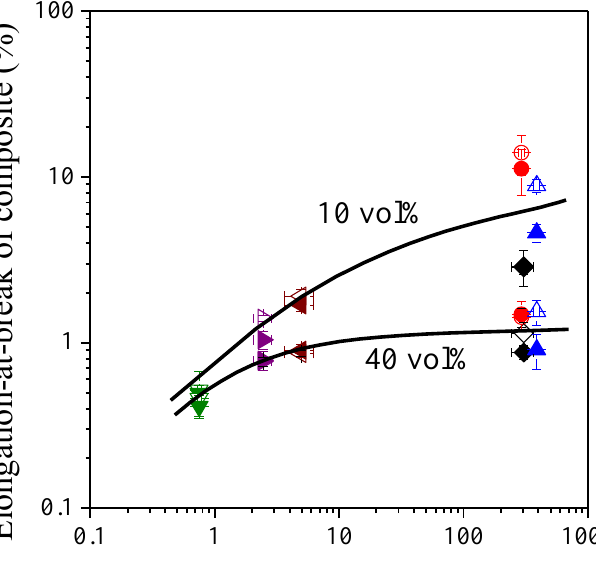
Figure 5. Effect of filler content on the brittleness of the composites. Symbols: (  ) PP; (  ) LDPE; Figure 2. Estimated moduli as a function of observed moduli representing the goodness-of-fit for (  ) HDPE; (  ) PS; (  ) PETG; (  ) PLA; empty symbols: SP20; full symbols: SPF. One trend line Figure 6. Correlation between the deformability of the matrix polymer and that of their composites the Lewis–Nielsen model. Symbols: (  ) PP; (  ) LDPE; (  ) HDPE; (  ) PS; (  ) PETG; (  ) PLA; with 10 vol% and 40 vol% filler content, respectively. Symbols: ( Figure 1. Effect of filler content on the stiffness of the composites. Symbols: (  ) PP; (  ) LDPE; (  ) ) LDPE; ( Figure 4. Effect of filler content on the strength of the composites.Symbols: (  ) PP; (  ) LDPE; (  ) ) HDPE; ( ) PS; Figure 9. Correlation between reversible work of adhesion and reinforcement in the composites Figure 8. Correlation between reinforcement and matrix strength in the composites studied. Sym- Figure 6. Correlation between the deformability of the matrix polymer and that of their composites Figure 6. Correlation between the deformability of the matrix polymer and that of their composites HDPE; (  ) PS; (  ) PETG; (  ) PLA; empty symbols: SP20; full symbols: SPF; Lewis–Nielsen model. HDPE; (  ) PS; (  ) PETG; (  ) PLA; empty symbols: SP20; full symbols: SPF. represents the LDPE composites having the highest deformability, and the other one represents the with 10 vol% and 40 vol% filler content, respectively. Symbols: (  ) PP; (  ) LDPE; (  ) HDPE; (  ) empty symbols: SP20; full symbols: SPF. studied.Symbols: (  ) PP; (  ) LDPE; (  ) HDPE; (  ) PS; (  ) PETG; (  ) PLA; empty symbols: SP20; bols: (  ) PP; (  ) LDPE; (  ) HDPE; (  ) PS; (  ) PETG; (  ) PLA; empty symbols: SP20; full symbols: ( with 10 vol% and 40 vol% filler content, respectively. Symbols: (  ) PP; (  ) LDPE; (  ) HDPE; (  ) with 10 vol% and 40 vol% filler content, respectively. Symbols: (  ) PP; (  ) LDPE; (  ) HDPE; (  ) much more rigid PLA composites. PS; (  ) PETG; (  ) PLA; empty symbols: SP20; full symbols: SPF. SPF. full symbols: PS; (  ) PETG; (  ) PLA; empty symbols: SP20; full symbols: SPF. PS; (  ) PETG; (  ) PLA; empty symbols: SP20; full symbols: SPF.